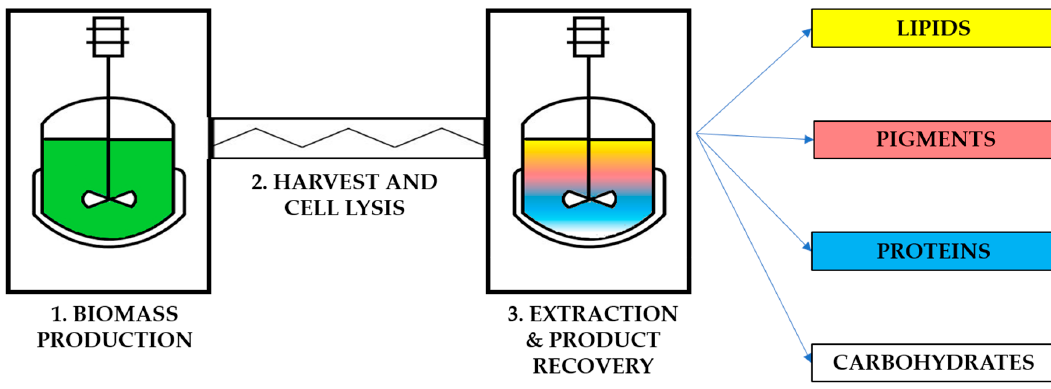
Figure 1. Schematic representation of a typical ‘microalgae biorefinery’. The first step involves biomass production, once the desired concentration of biomass is achieved, the algae need to be de-watered and lysed in order to work on a smaller volume and release the molecules of interest, in the final step, the different components have to be extracted and purified.